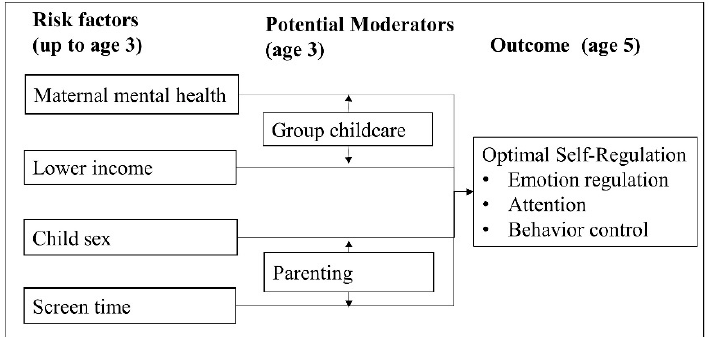
Figure 1. Risk factors and potential moderators of self-regulation. Risk factors (maternal mental health, lower income, child sex, and screen time) were measured at age 3 (or at birth in the case of child sex). Group childcare (at age 3) is hypothesized to moderate the association between maternal mental health or lower income and self-regulation. Parenting behaviors (at age 3) are hypothesized to moderate the association between child sex or screen time and self-regulation.